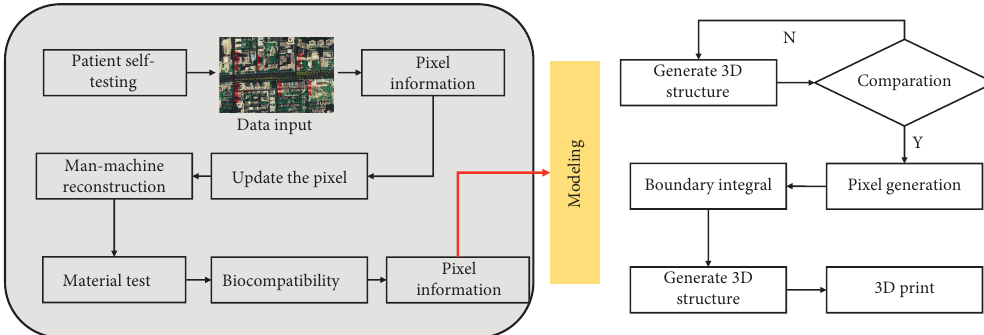
Figure 9: Performance analysis of the city model.